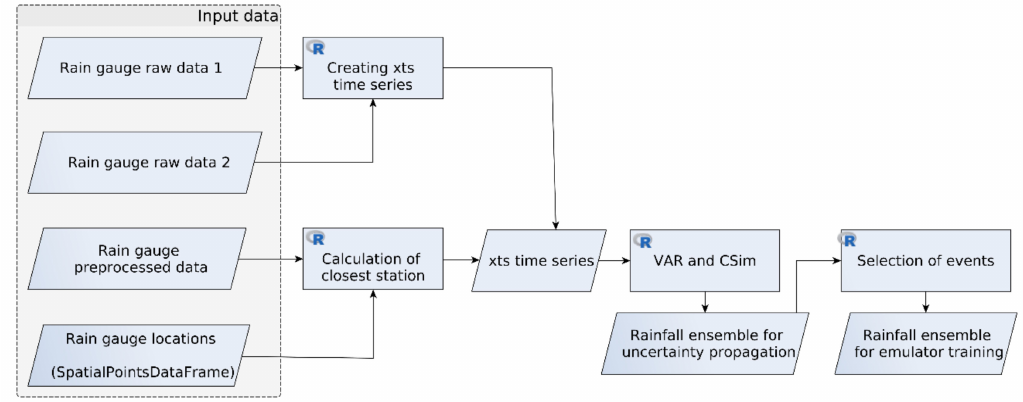
Figure 2. Workflow for the multivariate autoregressive (VAR) modelling and conditional simulation (Csim), and event selection for the rainfall